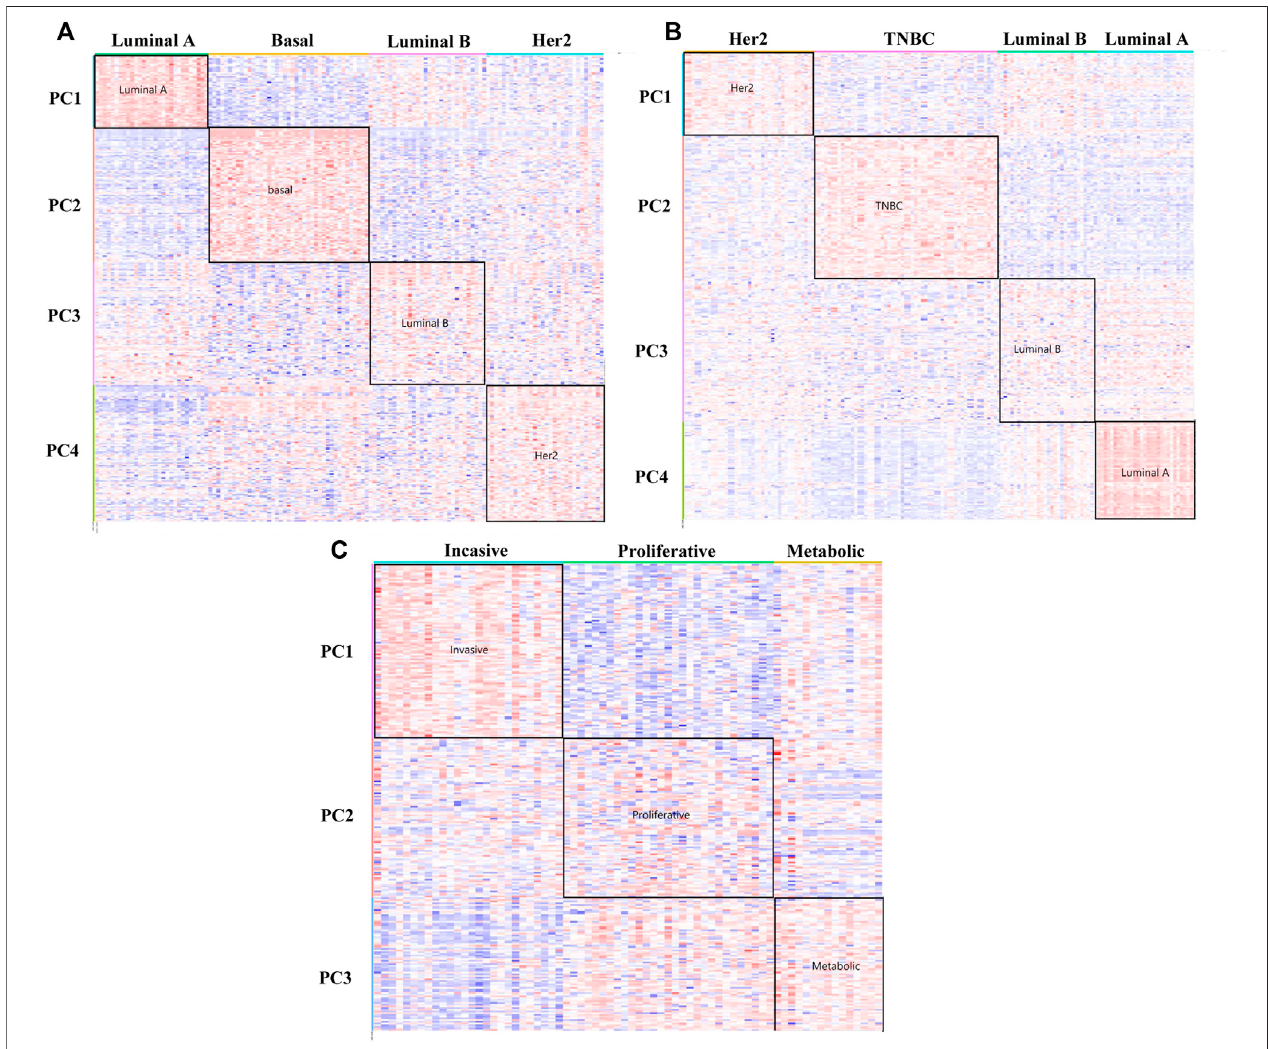
FIGURE 3 | Heat maps of the DM-ESPCA model. (A) Result of the BCI data set. (B) Result of the BCII data set. (C) Result of the GC data set. The row is the gene probs; different color blocks of rows indicate genes selected by different PC loadings. The column is the samples. The color of each block in the heat maps is the expression value of the genes.